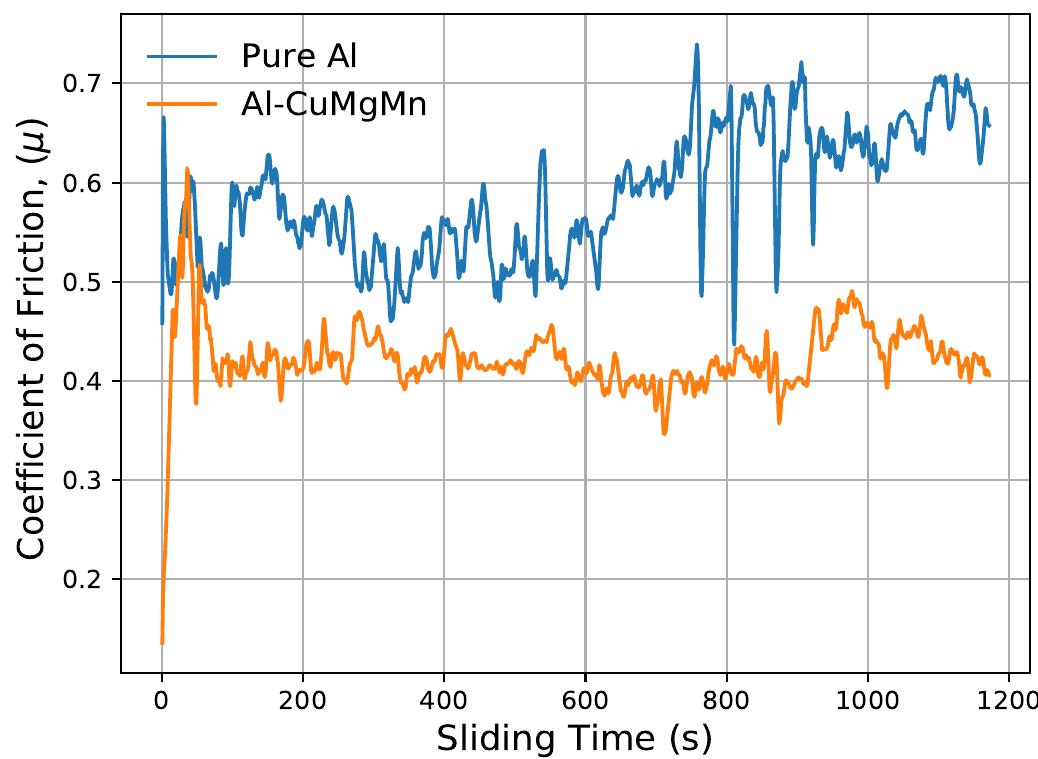
Figure 13. Comparison of coefficient of friction for substrate material and laser-surface-alloyed samples when 20 N load and 2 m/s sliding speed are used